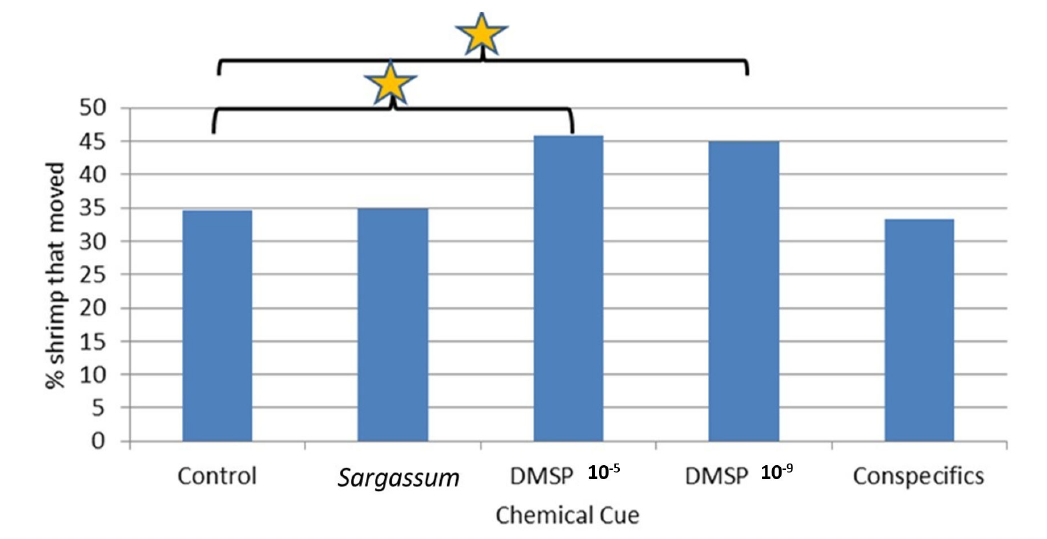
Figure 7. Number of Latreutes fucorum female shrimp that moved out of area C in the Y-maze for the control, Sargassum , DMSP 10 − 5 M, DMSP 10 − 9 M, and conspecific cue trials (binomial test; Sargassum , p = 0.11; DMSP 10 − 5 , p = 0.01; DMSP 10 − 9 , p = 0.02; and conspecifics, p = 0.11). Star/bracket indicates significant differences between indicated paired groups.